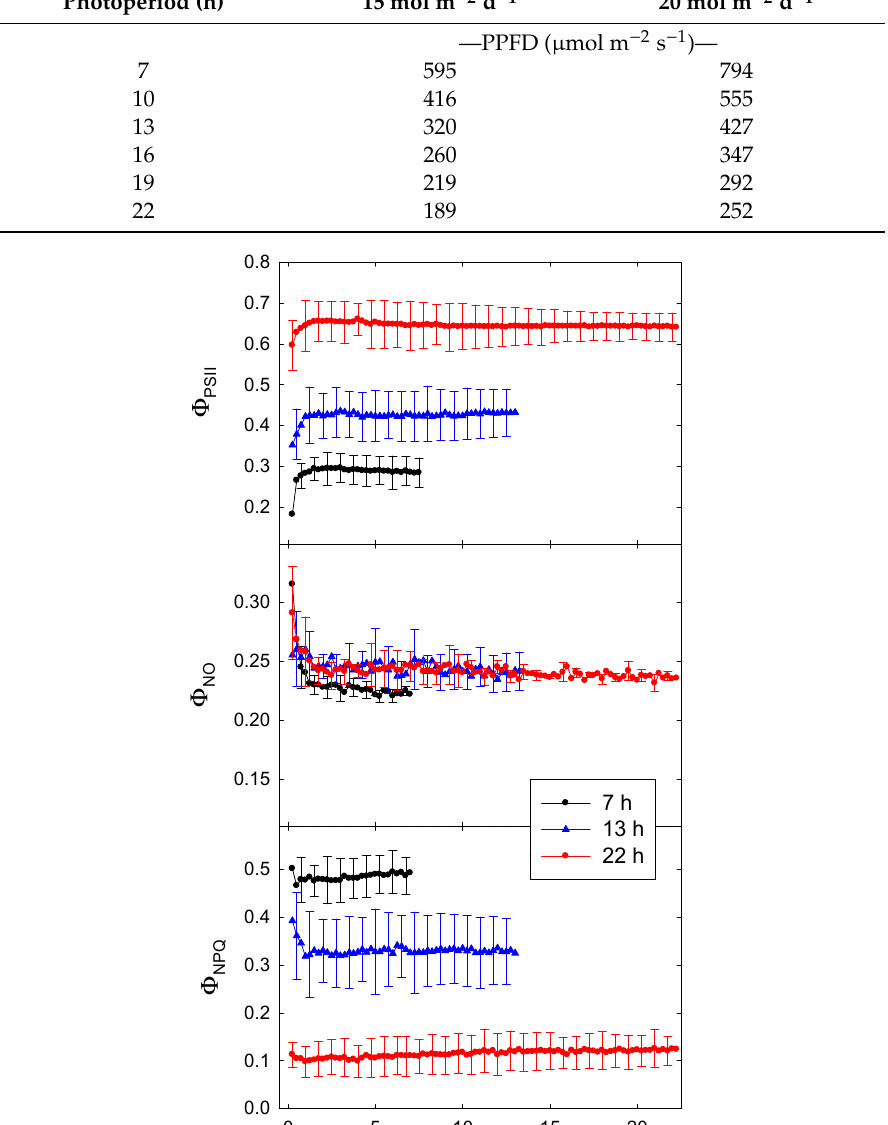
Figure 1. The quantum yield of photosystem II ( Φ PSII , top), the quantum yield of non-light-induced energy dissipation ( Φ NO , middle), and the quantum yield of light-induced energy dissipation ( Φ NPQ , bottom) of lettuce ( Lactuca sativa ‘Green Towers’) under three different photoperiods (7, 13, and 22 h) with a daily light integral (DLI) of 20 mol m − 2 d − 1 . Data are the means of three replications ± SD.